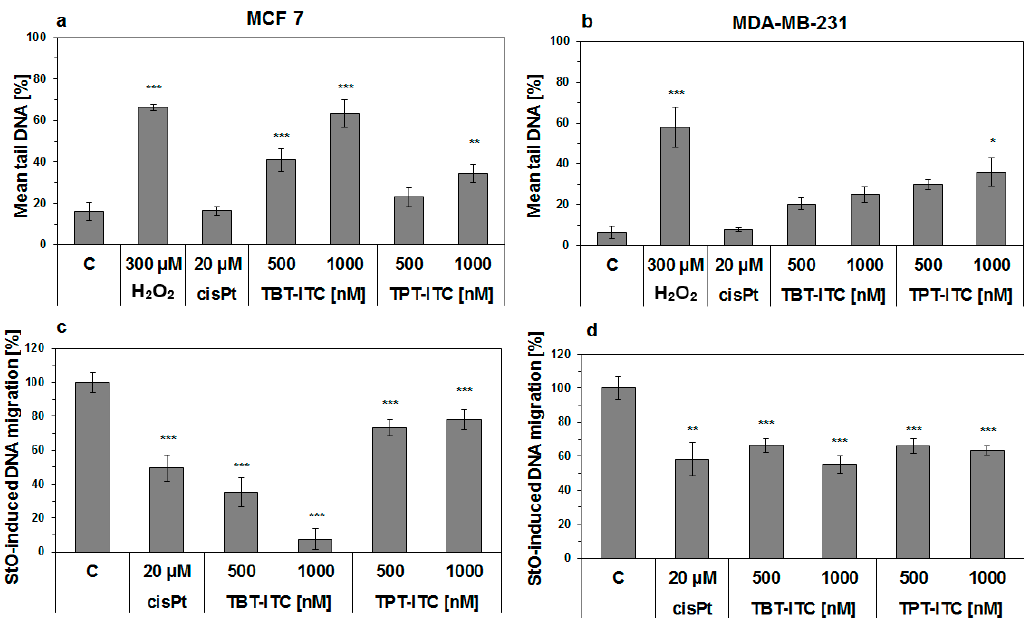
Figure 3. DNA damage (alkaline comet assay) caused by treatment with 500 and 1000 nM TBT-ITC and TPT-ITC in human breast cancer MCF 7 ( left ) and MDA-MB-231 cells ( right ) expressed either as a mean percentage of tail DNA (DNA-damaging 300 µ M hydrogen peroxide, H 2 O 2 , was used as a positive control) ( a , b ); or as a percentage of StO-induced DNA migration (crosslinking 20 µ M cisplatin, cisPt, was used as a positive control) ( c , d ). Results are presented as the means of three independent experiments ± standard deviation (SD). Statistically significant differences * p < 0.05, ** p < 0.01, *** p < 0.001 in comparison to the negative (untreated) control (C).